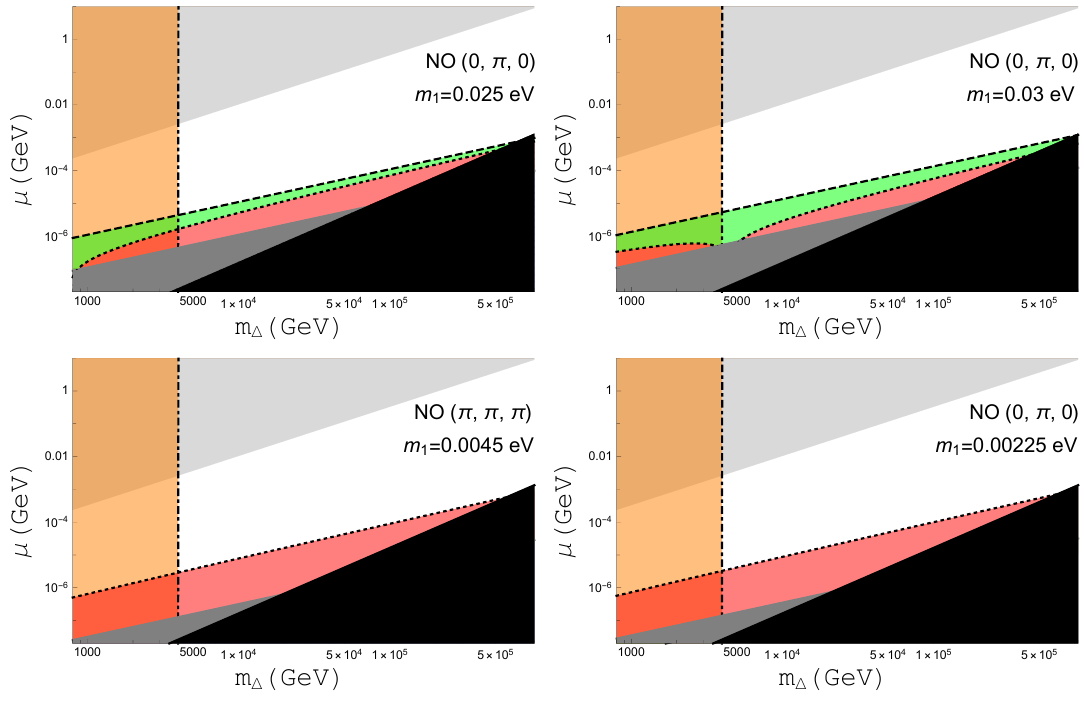
Figure 8 . The experimental sensitivities of LFV searches for the successful Type II Seesaw Leptogenesis parameter space is depicted for different CP phases parameter sets ( δ CP , α 21 , α 31 ) in the NO scenario with varying m 1 around special